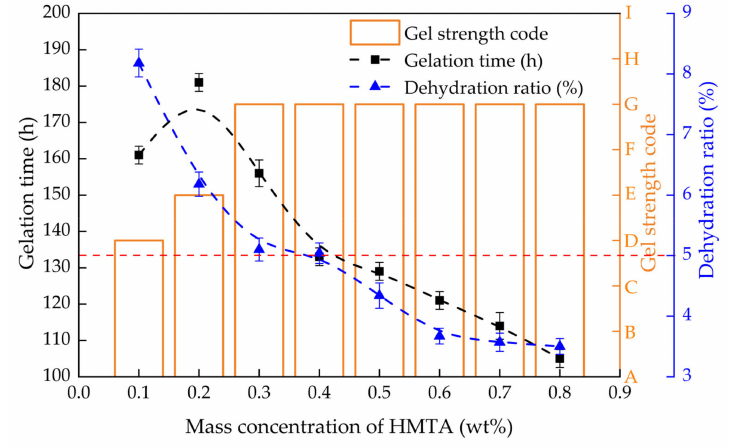
Figure 5. Gelling performance with different concentrations of HMTA (0.4 wt% PAM+ 0.05 wt% RO+ 0.3 wt% OA).